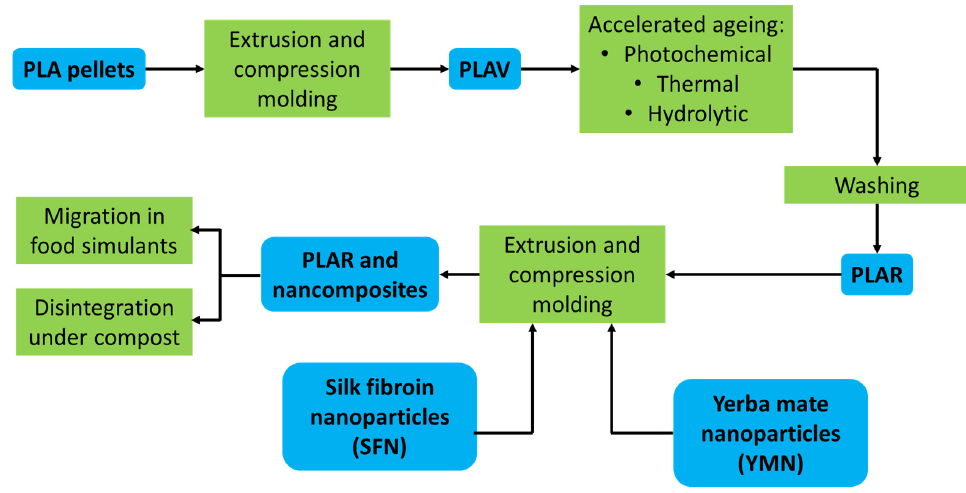
Figure 3. Scheme of the recycling of poly(lactic acid) (PLA) and the manufacturing of nanocompo- sites.